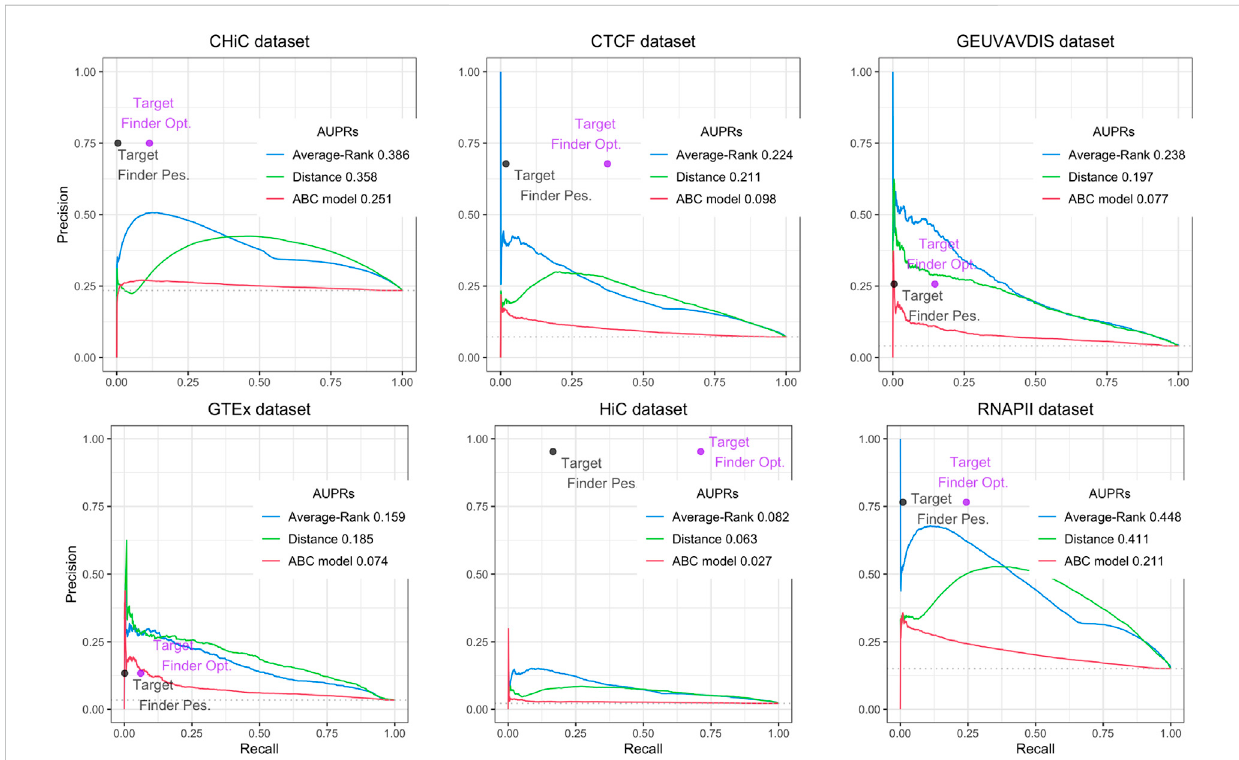
FIGURE 3 Performancesof Average-Rank , distance , ABCmodel and TargetFinder methodsonthesixdatasetsoftheGM12878 BENGI evaluationset(all pairs,naturalratio).Foreachmethodexcept TargetFinder ,aPrecision-RecallcurveandanAUPR(AreaUnderthePrecision-Recallcurve)areprovided. For TargetFinder , the two dots, TargetFinder_pes and TargetFinder_opt , correspond to two different ways of computing recall, a pessimistic and an optimistic one (see Material and methods and Table 2 for more